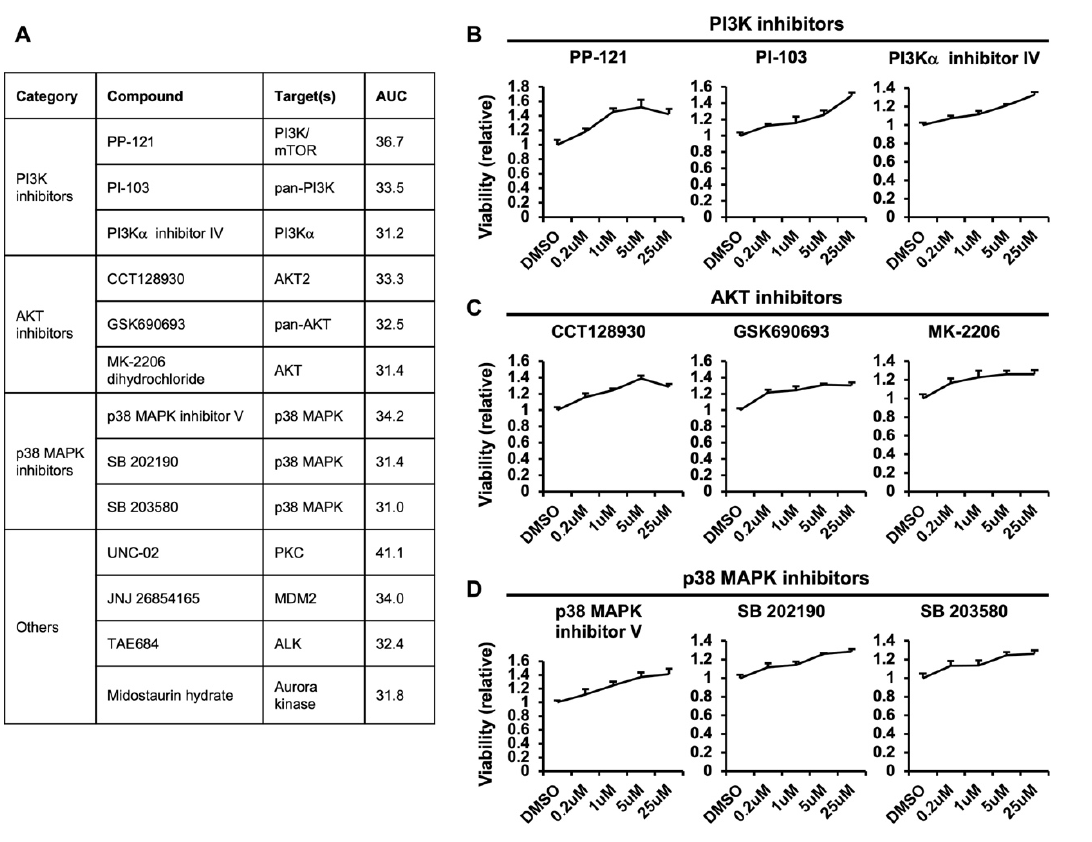
Figure 4. Negative regulators of macropinocytosis-dependent growth. ( A ) Compounds that lead to an increase in AUC, including known targets and AUC value. ( B ) Relative viability of cells treated with various concentrations of the PI3K inhibitors PP-121, PI-103, and PI3K α inhibitor IV. ( C ) Relative viability of cells treated with various concentrations of the AKT inhibitors CCT128930, GSK690693, and MK-2206. ( D ) Relative viability of cells treated with various concentrations of the p38 MAPK inhibitors p38 MAPK inhibitor V, SB 202190, and SB 203580.